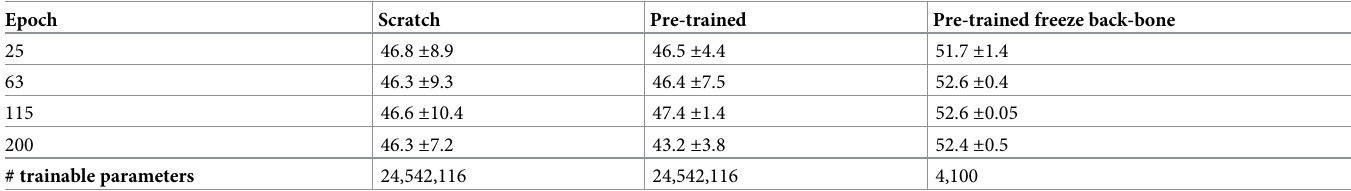
Table 9. Global average F1-scores for domain transfer experiments for I3D, using varying pre-training and fine-tuning schemes. The model is trained on the PF data- set and tested on the EOP(j) dataset. Only the pre-trained model, fine-tuned with a frozen back-bone could achieve results slightly above random performance on EOP(j).